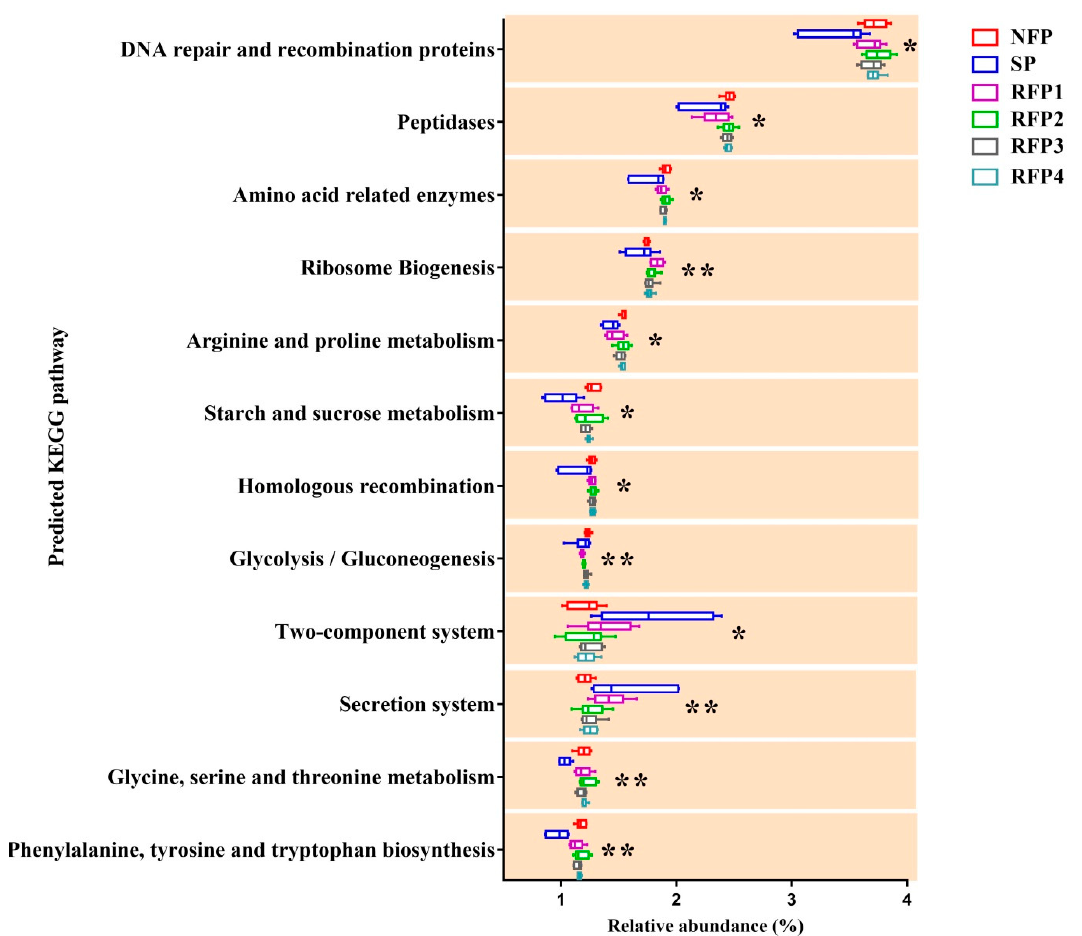
Figure 5. Comparisons of PICRUSt predicted functional pathways in the rumen microflora of yaks over the experimental periods (* p < 0.05, ** p < 0.01).